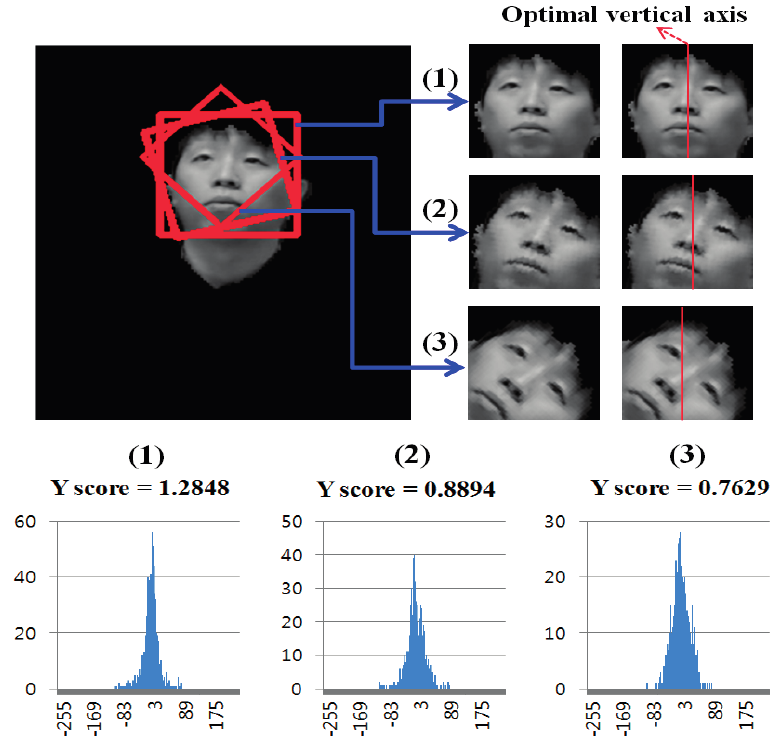
number (histogram) of the corresponding GLD, respectively [12]. Figure 8. Examples of GLDH and Y